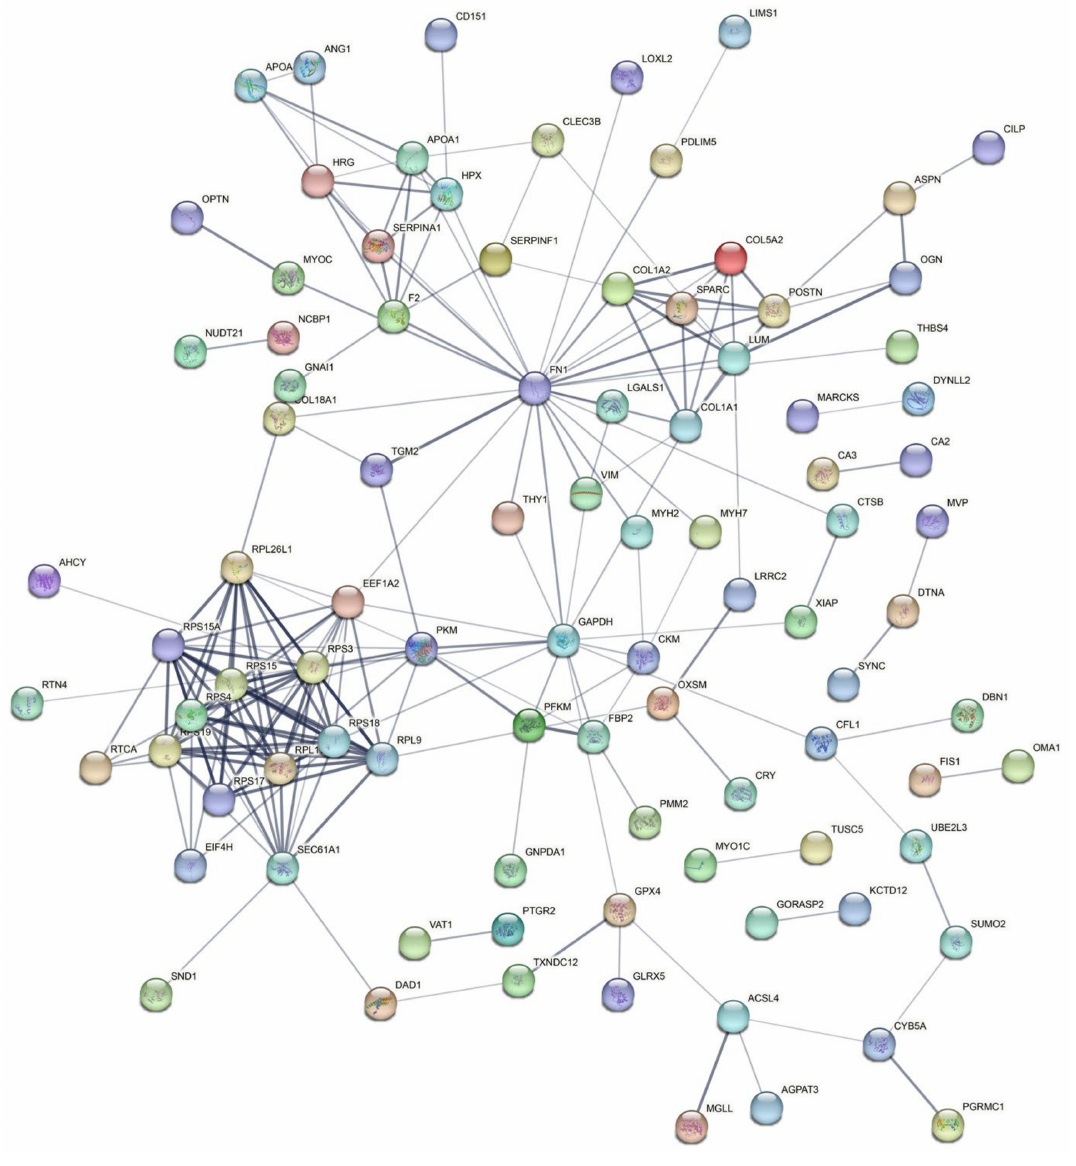
Figure 5. Protein–protein interaction (PPI) regulatory network analysis of the DEPs. The lines represent proteins that interact with each